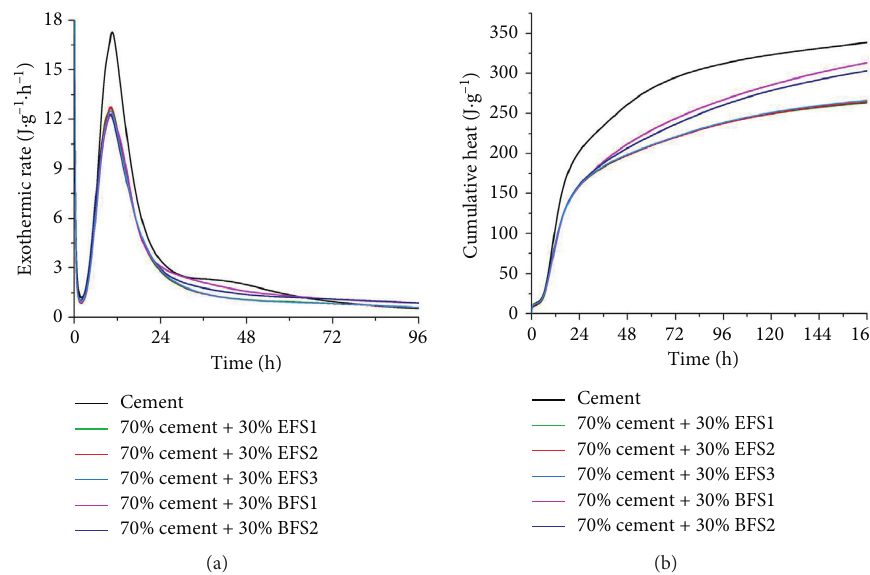
Figure 2: Effects of FNS on cement hydration kinetics. (a) Exothermic rate and (b) cumulative heat